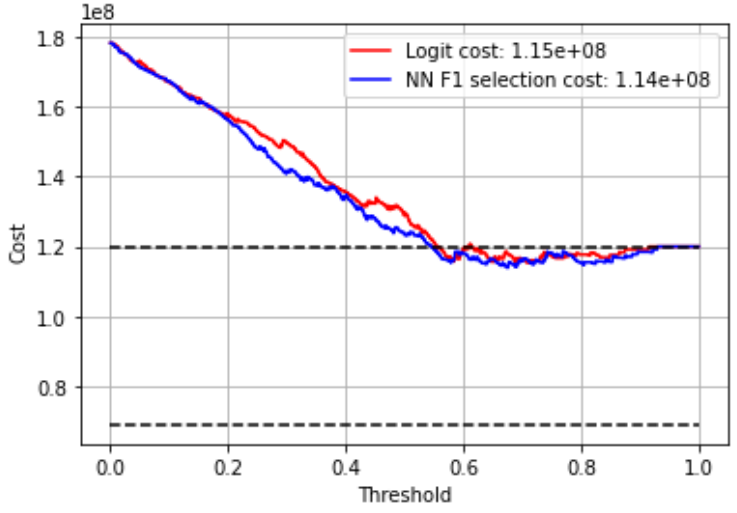
Figure 11. Policyholder-related